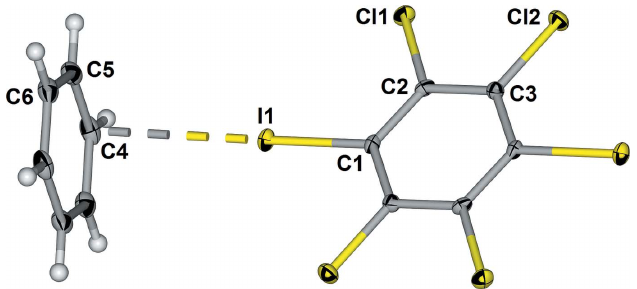
Figure 1 The asymmetric unit of the title solvate showing the atom-numbering scheme. Displacement ellipsoids of non-hydrogen atoms are drawn at the 50% level while H atoms are shown as circles of arbitrary size. The intermolecular C—I (cid:2)(cid:2)(cid:2) (cid:2) contact is shown as a dashed